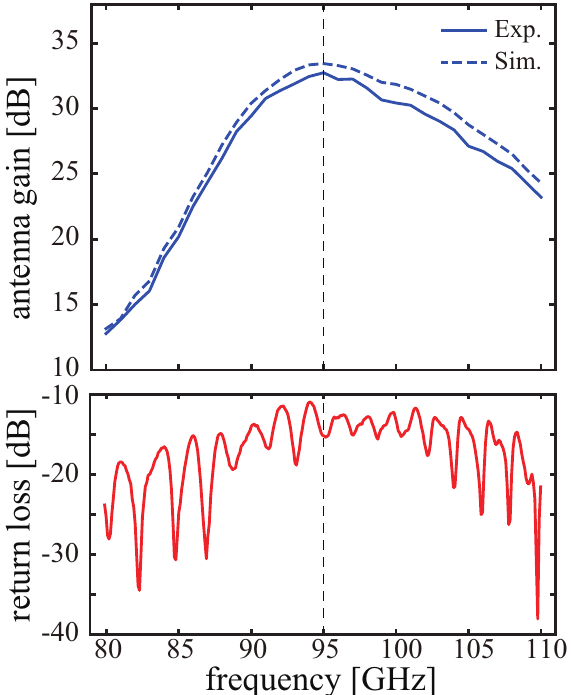
Figure 9. Measured (solid line) and simulated (dashed line) antenna gain and return loss ( θ = − 20 ◦ ) versus millimeter-wave frequency of the reconfigurable